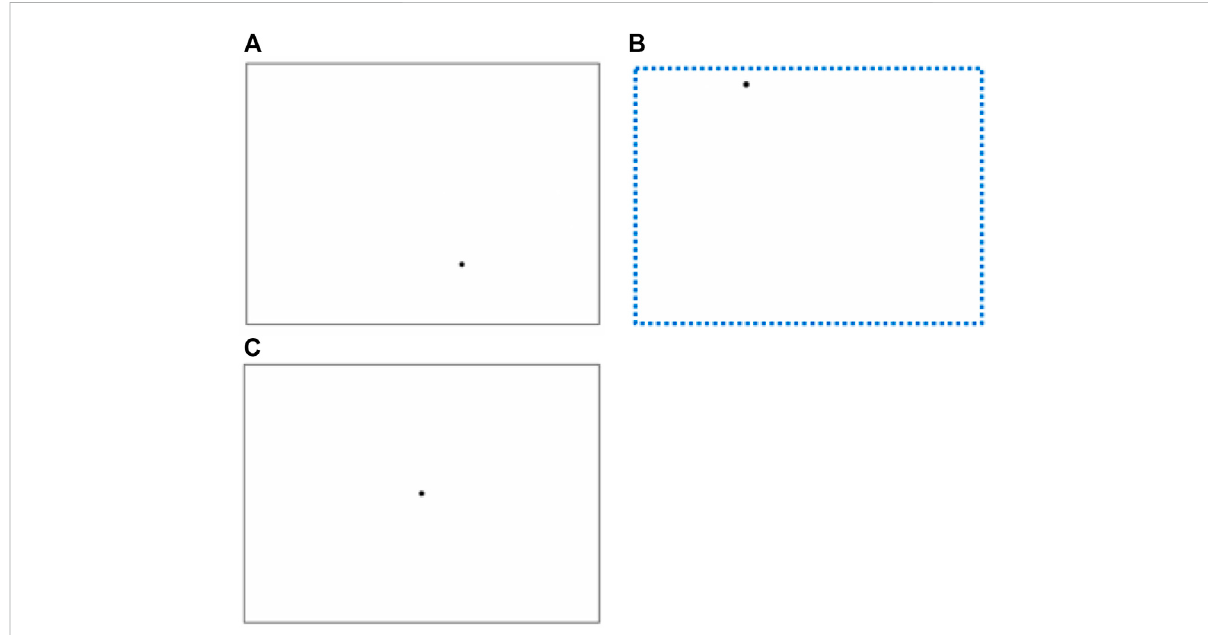
FIGURE 1 Stimuli in experiment. The above three fi gures reveal ‘ Stimuli inthe learning stage of SSWM task ’ (A) , ‘ Stimuliin thelearning stage of DSWM task ’ (B) (There are no dashed tracks in the formal experiment), ‘ Stimuli in the test stage of SSWM and DSWM task ’ (C)